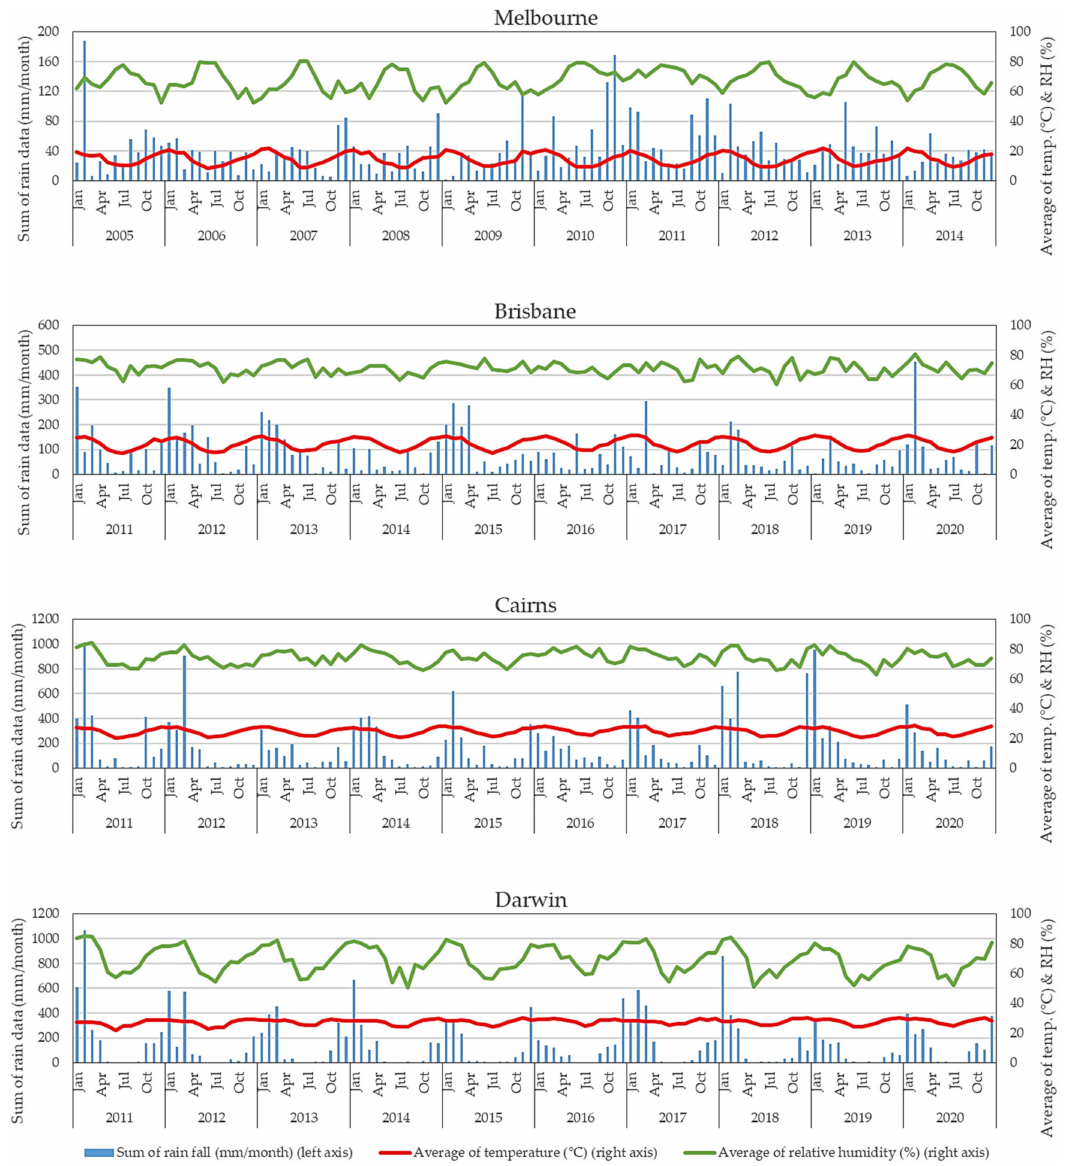
Figure 3. 10-year climate files generated from the NCEI archives. Note the different range of years used for Melbourne and the different y-axis bounds for the sum of monthly rain data. Table 2. Indoor